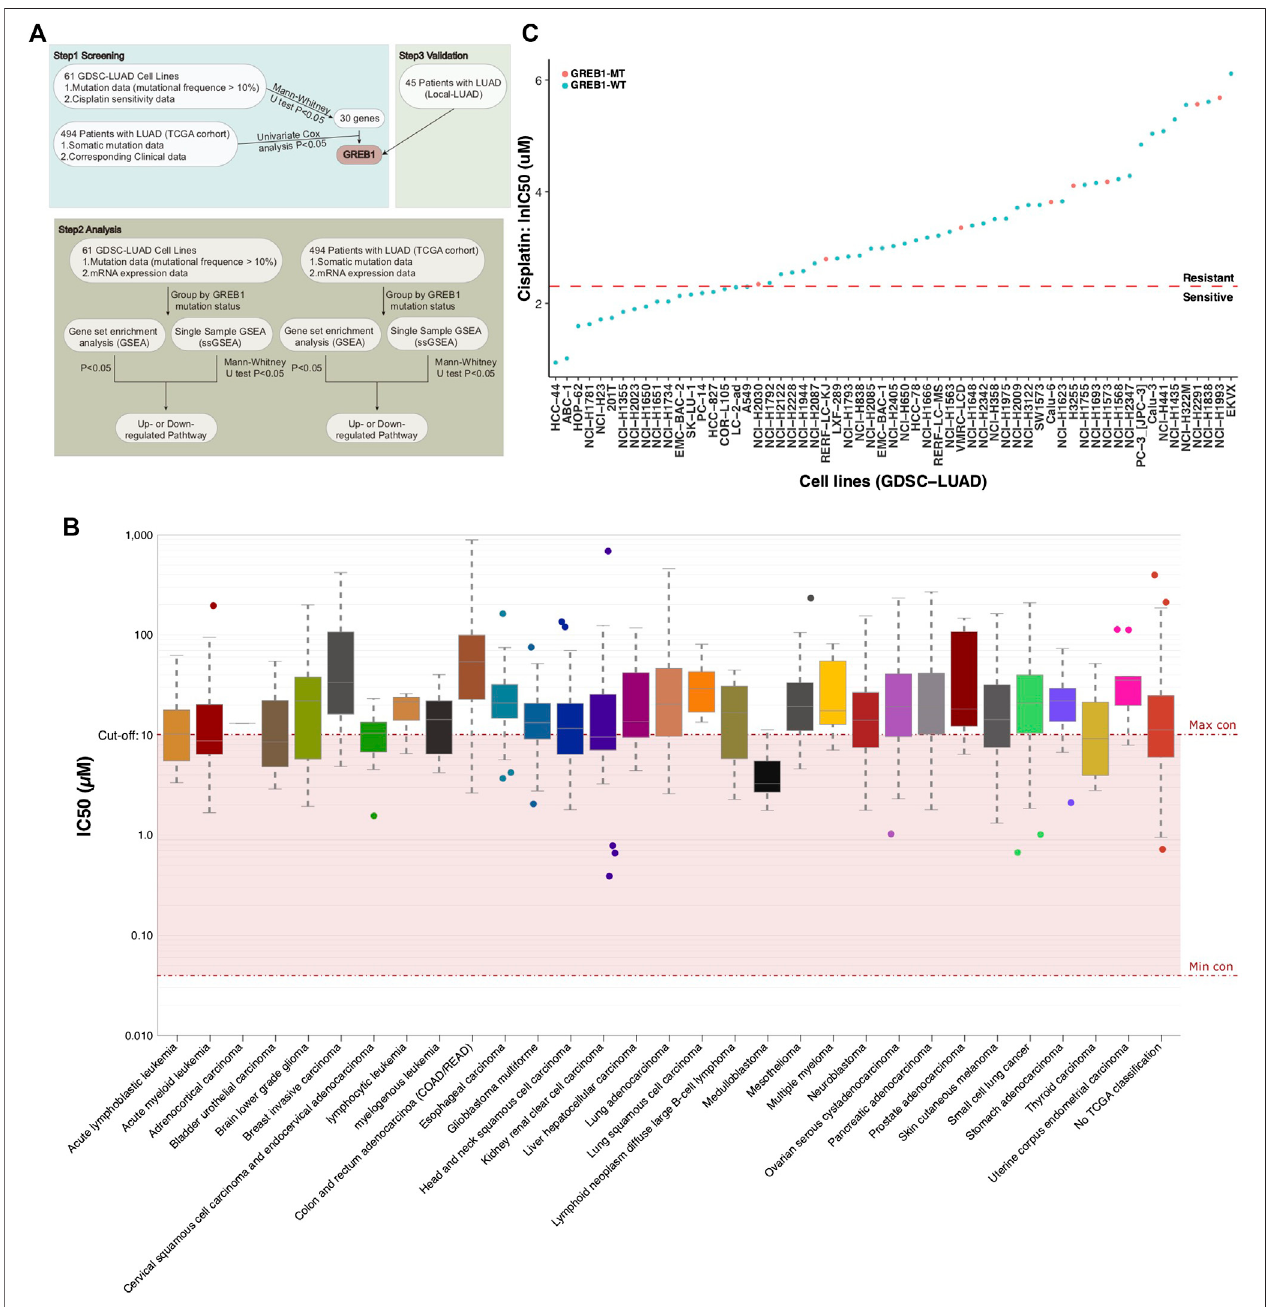
FIGURE 1 | (A) The work fl ow of the bioinformatics analysis. (B) The IC50 distribution for CDDP by tissue type. (C) Scatter plot of the IC50 distribution for CDDP in sixty-one LUAD cell lines. IC50, half maximal inhibitory concentration; LUAD, lung adenocarcinoma.